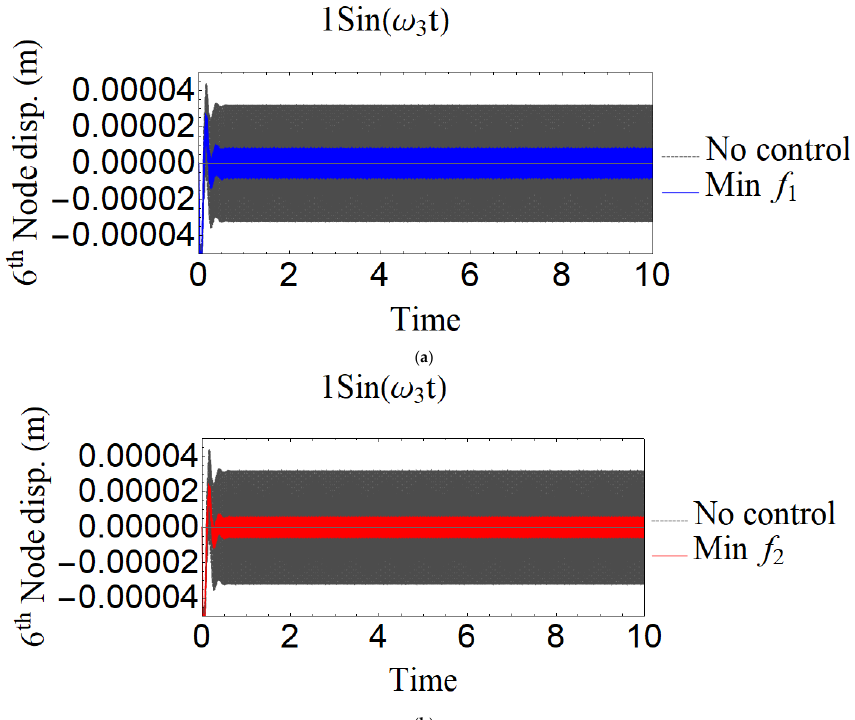
Figure 9. Time history response of the vertical displacement of the 6th node of the cantilever beam under the third mode harmonic base excitation considering ( a ) f 1 and ( b ) f 2 objective